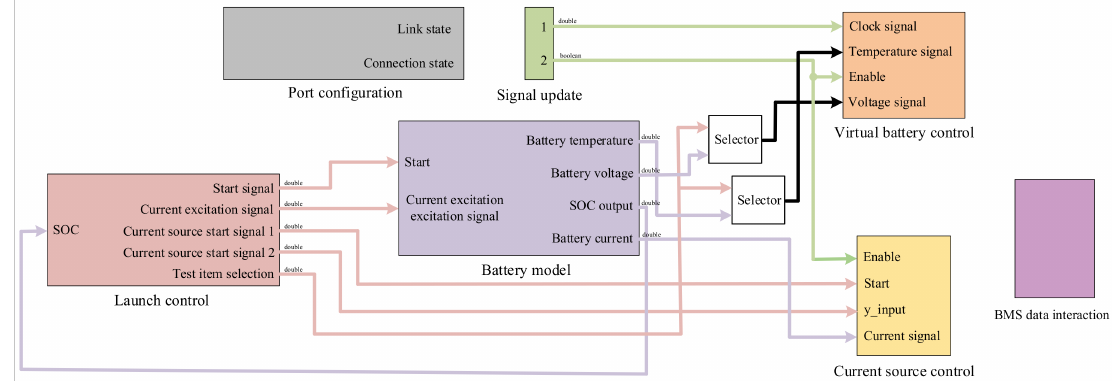
Figure 5. The software part of battery management system testing